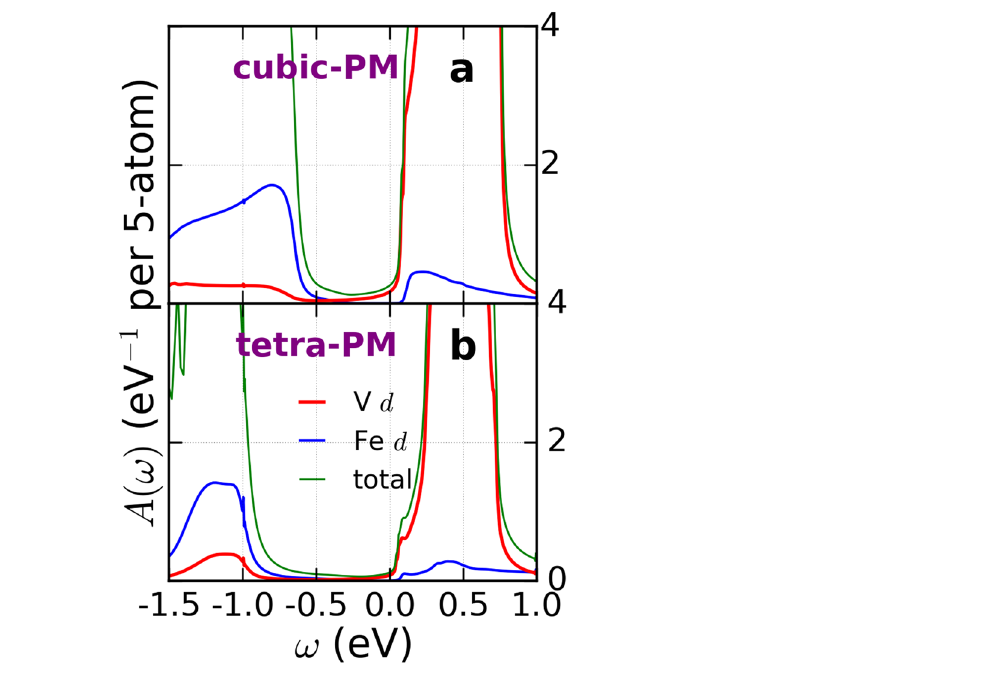
Figure 5. Spectral functions A ( ω ) of cubic and tetragonal Ba 2 VFeO 6 . The unit of A ( ω ) is eV − 1 per 5-atom. Panel a is for cubic Ba 2 VFeO 6 and panel b is for tetragonal Ba 2 VFeO 6 . In both structures, we calculate the paramagnetic state. The red, blue and green curves are for Fe d , V d and O p , respectively. The Fermi level is set at ω = 0